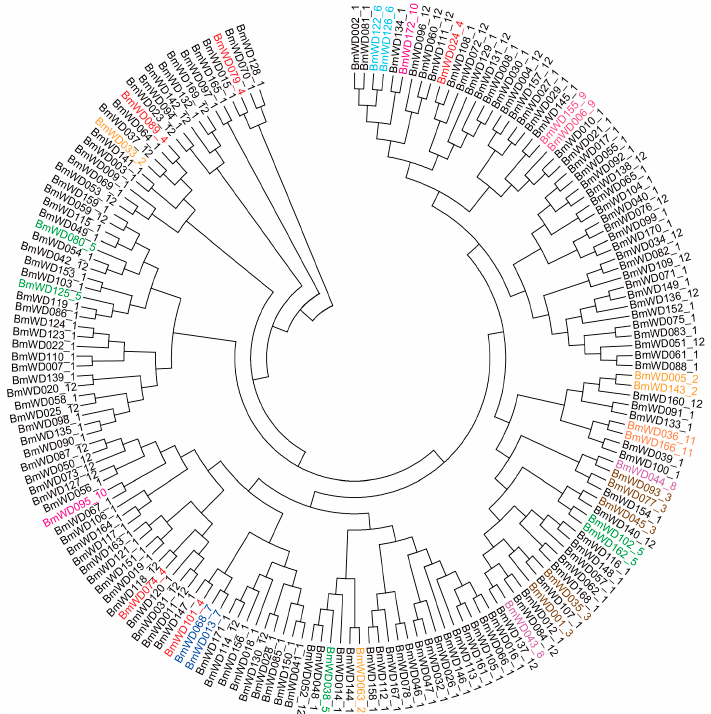
Figure 5. WD40 domain sequence-based phylogenetic tree of Bm WD40 proteins. MEGA6 was used to construct the phylogenetic tree using the neighbor-joining method with 1000 bootstrap replicates. Multi-domain Bm WD40 proteins from each class (i.e., from Class 2–Class 11) with multiple members for each domain-architecture are indicated by the same colors, respectively.